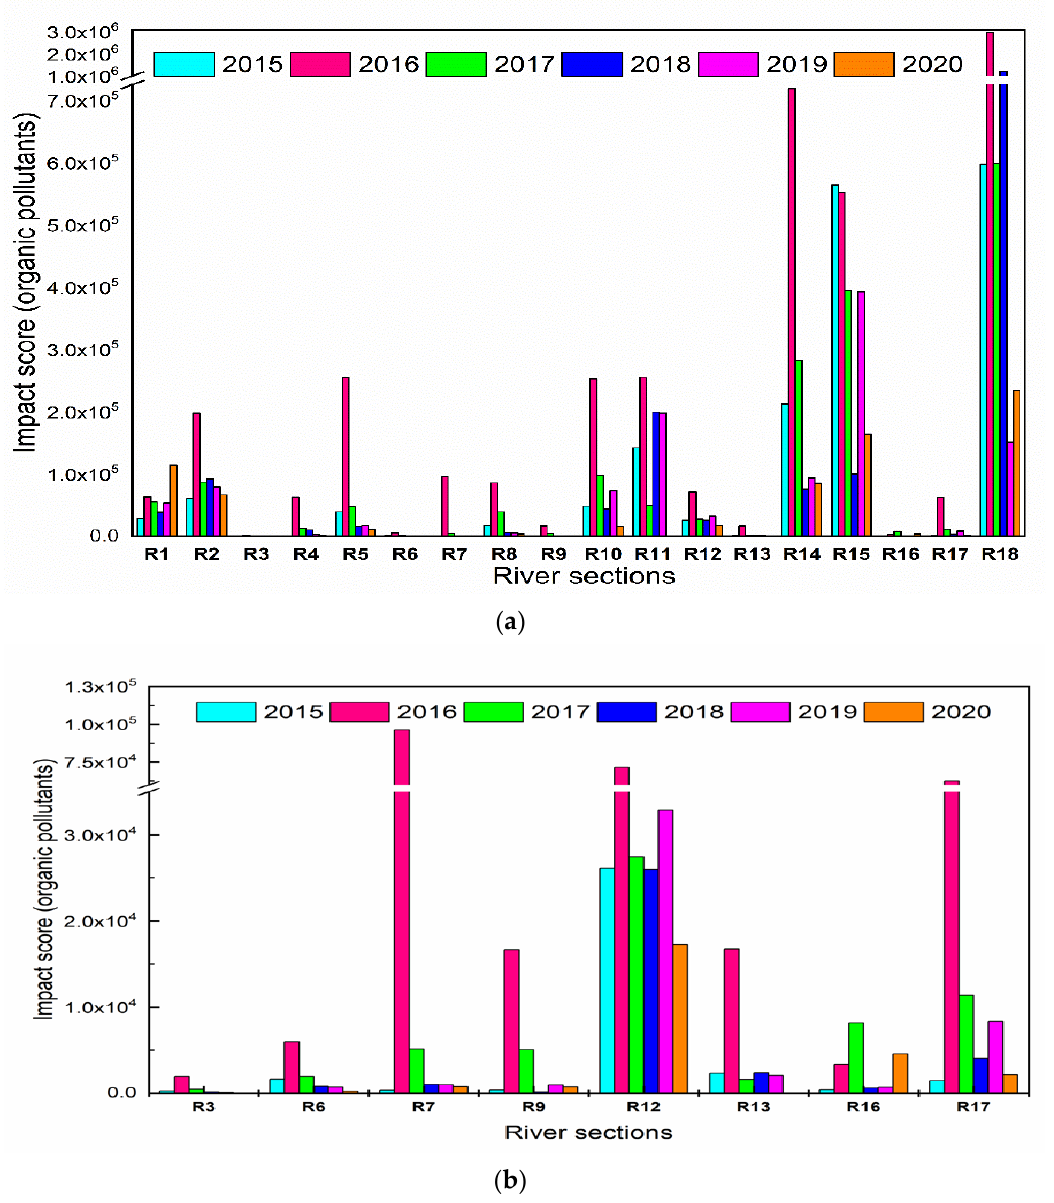
Figure 5. Ecotoxicity impact scores generated by organic pollutants (2015–2020): ( a ) R1-R18 sections on the original scale; ( b ) a deeper view of selected sections (R3, R6, R7, R9, R13, R16, R17). Table 8. Total impact scores obtained in the period 2015–2020 and the contribution of organic